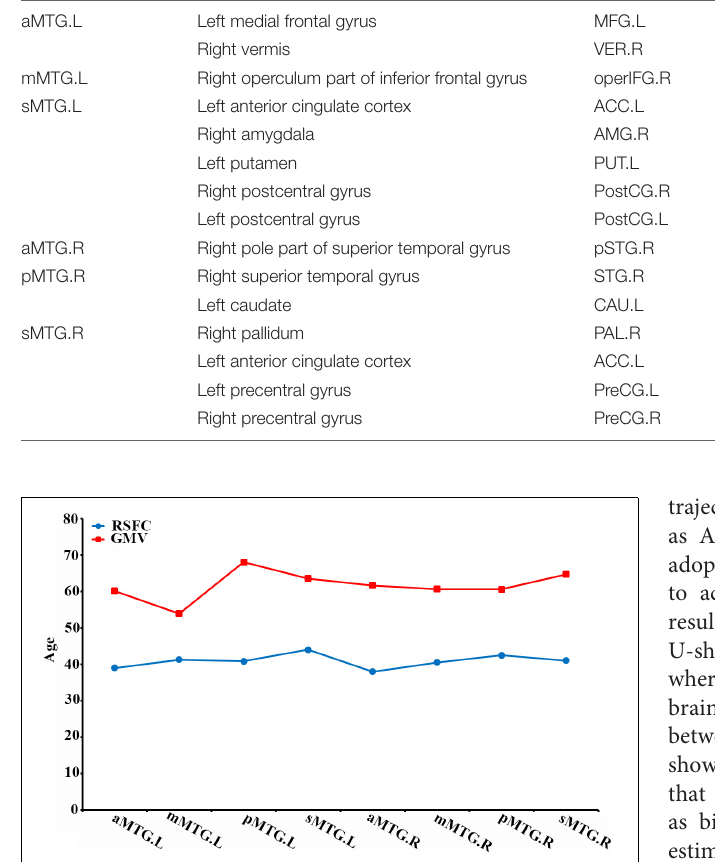
TABLE 1 | Brain regions that showed a quadratic relationship between RSFC of MTG sub-regions and age. Seed regions